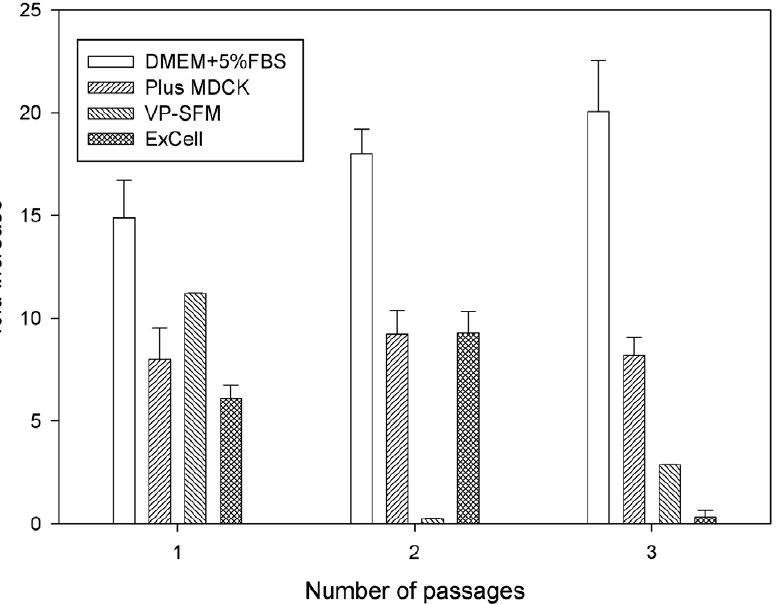
Figure 1. Comparison of MDCK cell growth in different culture medium. Three commercially available serum-free media (Plus-MDCK, VP- SFM, and ExCell) and one SC medium (DMEM + 5% FBS) were used to evaluate the suitability for MDCK cells directly grown in 75 cm 2 T-flasks. The thawed MDCK cells were directly cultured in four different media over 3 passages. The cell numbers were determined based on the harvest when the cell grown in SC had reached 90% confluency in day 3. The cell count in each medium was performed in triplicate. The increase of cell growth (number of fold increase) is calculated based on the final total cell number divided by the initial cell number.